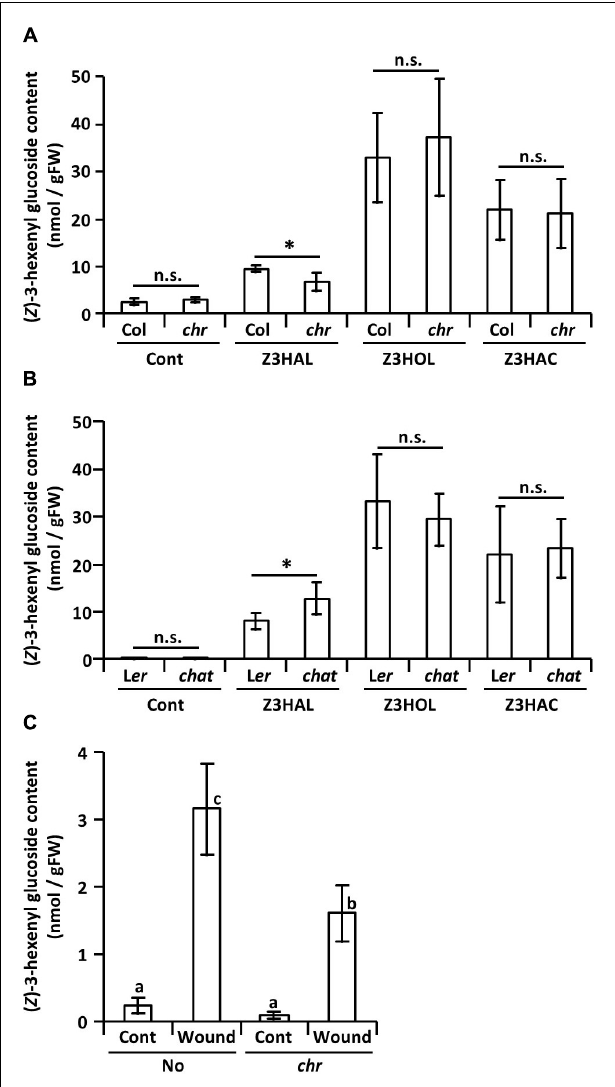
FIGURE 5 | Accumulation of ( Z )-3-hexenyl glucoside in GLV-exposed and wounded Arabidopsis plants. Comparison of the amount of ( Z )-3-hexenyl glucoside between (A) the chr mutant and its corresponding wild type (Col) plants and (B) the chat mutant and its corresponding wild type (L er ) plants after ( Z )-3-GLVs exposure. Wild types and mutants are exposed together in the same plexiglass box as described in Materials and Methods. Data are shown as mean ± SE ( N = 5–7). The difference between the wild types and mutants was analyzed by t -test ( ∗ p < 0.05). (C) The amount of ( Z )-3-hexenyl glucoside in the chr mutant and its corresponding wild type (No) plants with or without wounding (Wound/Cont) was compared, data are shown as mean ± SE ( N = 6–20). Different letters indicate the significant difference ( p < 0.05; Tukey’s multiple comparisons).